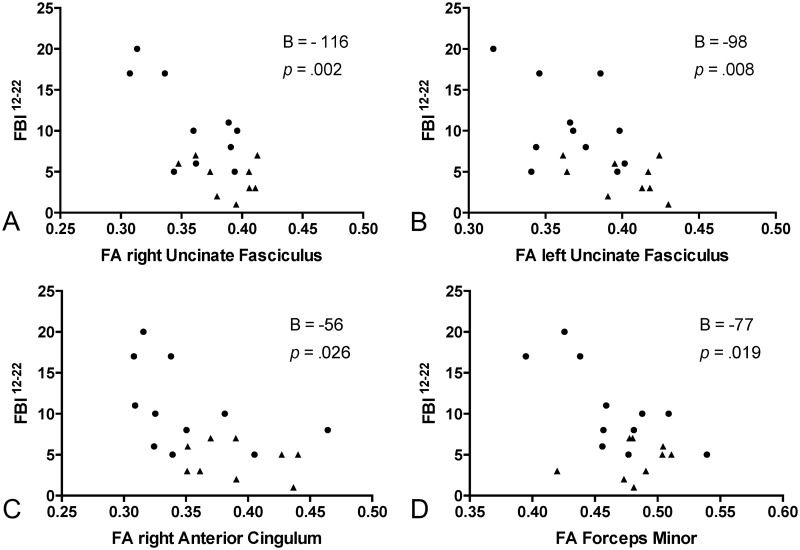
Frontal Behavioural Inventory and FA of tracts.Scatter plots of Frontal Behavioural Inventory composite score of items 12–22 (FBI12-22) and fractional anisotropy (FA) of tracts in patients with behavioural variant frontotemporal dementia (bvFTD) (dots) and progressive supranuclear palsy (PSP) (triangles), for A: the right uncinate fasciculus, B: the left uncinate fasciculus, C: the anterior cingulum and D: the forceps minor. B (adjusted) and p are derived from the linear regression model, with age as covariate.